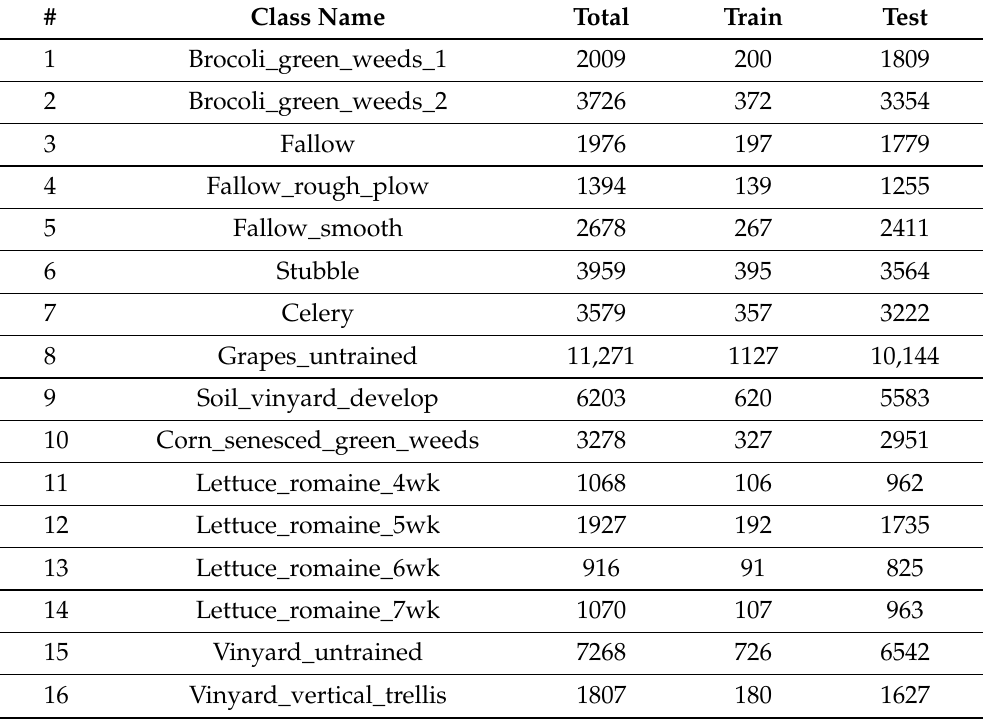
Table 3. Number of train and test sample in the Salinas dataset.